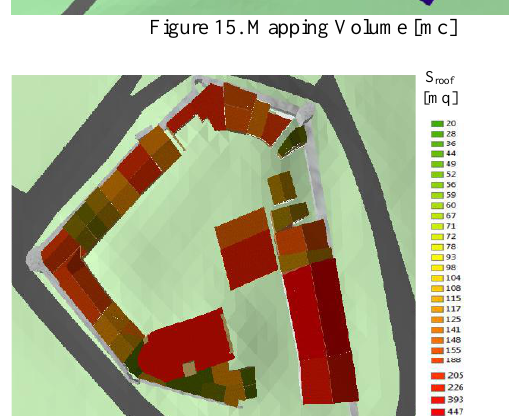
Figure 16. LOD1, mapping roof surface